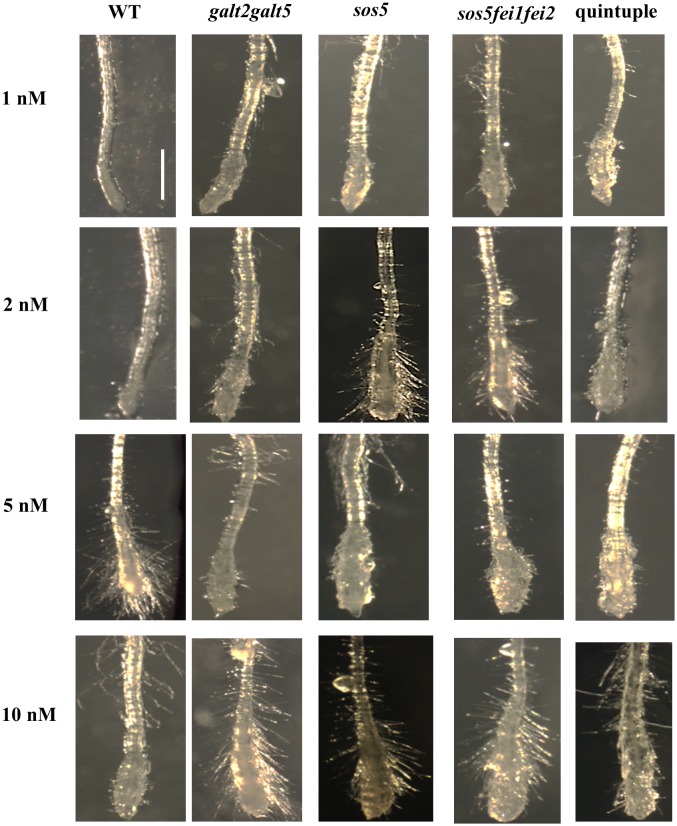
Hypersensitivity of the mutants towards isoxaben.Root tips from WT and mutant seedlings were germinated and grown for five days on MS medium with 1% sucrose and transferred for 72 hours to MS medium supplemented with isoxaben at various concentrations. Root tips were imaged using dark field microscopy. Scale bar = 1 mm.